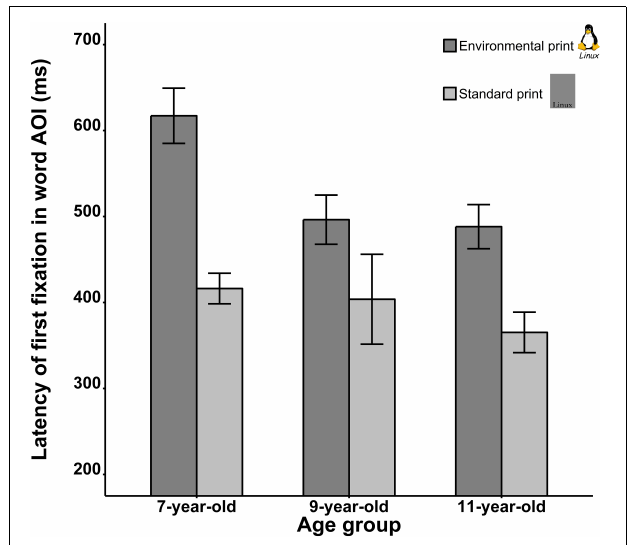
FIGURE 3 | Mean latencies of the first fixation in word AOIs in EPs and SPs across three age groups. Error bars denote ± SEM.